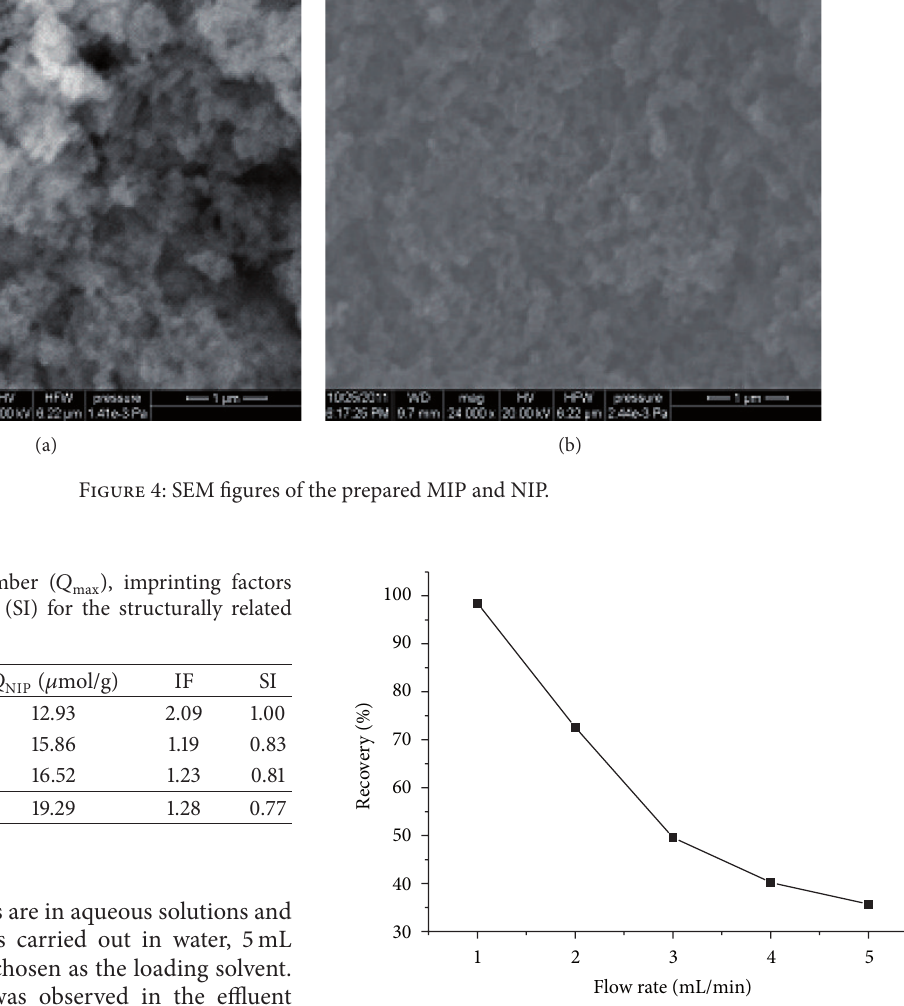
Figure 5: Optimization of the flow rates of loading